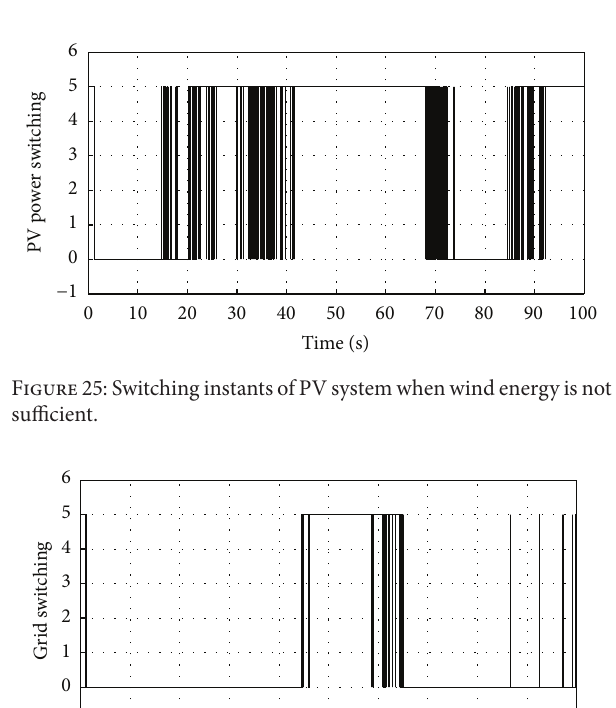
Figure 24: Peak power changes obtained from WES using FLR algorithm.